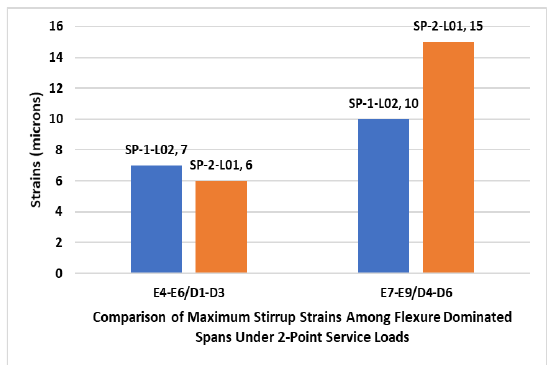
Figure 32. Comparison of maximum stirrup strains recorded for loading setup SP-1-L02 and SP-2-L01under two-point service loads.